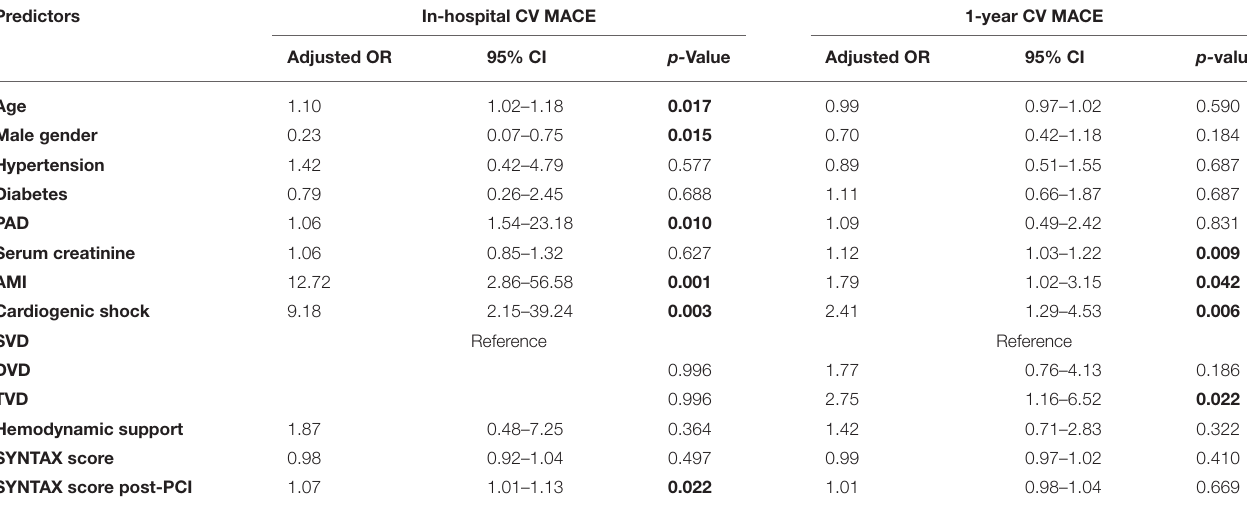
TABLE 5 | Predictors of cardiovascular major adverse cardiovascular events (CV MACE) during hospitalization and at 1-year follow-up from the multivariable models.